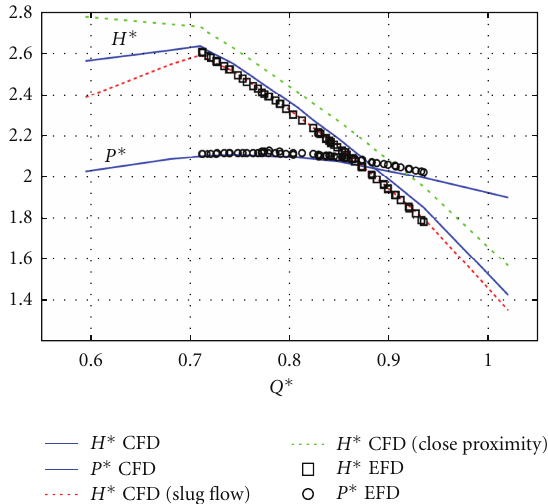
Figure 2: Single-phase flow. Waterjet pump, AxWJ-2, power- ing iteration integrated results. Dimensionless power [ P ∗ = (Power) / ( ρn 3 D 5 )] and head rise [ H ∗ = gH/ ( n 2 D 2 )] versus flow rate [ Q ∗ = Q/ ( nD 3